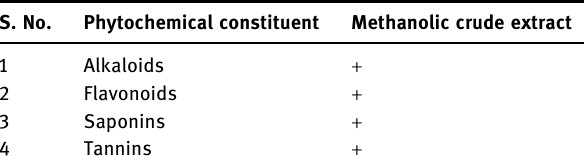
Table 2: The phytochemical constituents of Eucalyptus obliqua methanolic crude extract S. No.